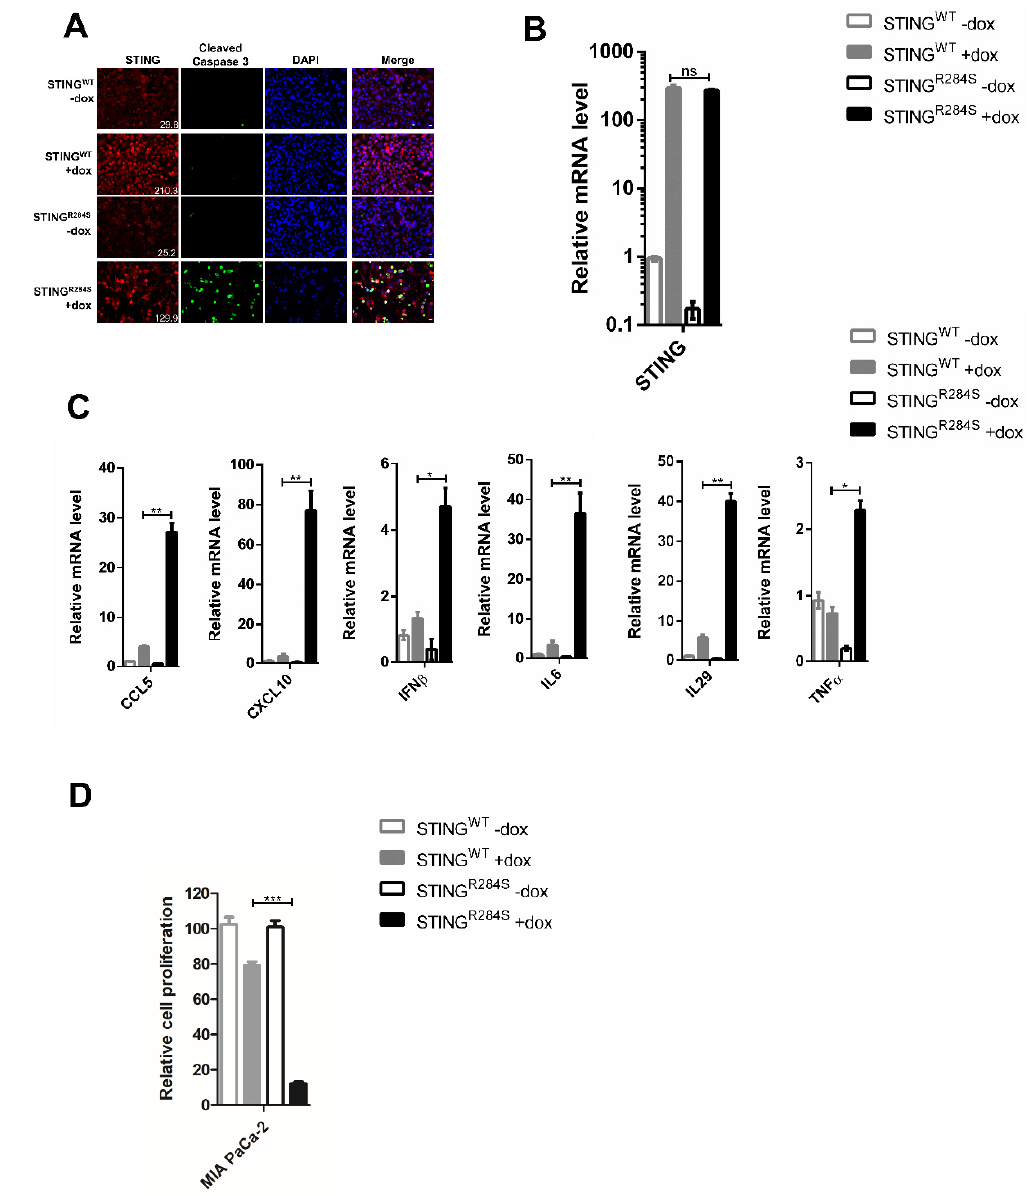
Figure 3. Ectopic expression of dox-inducible STING R284S induces key antitumor cytokine production and cell death in PDAC cells. ( A – C ) MIA PaCa-2 cells stably expressing STING WT or STING R284S were treated with or without 5 µ g/mL dox for 48 h. ( A ) The cells were stained for STING (Red) and Cleaved Caspase-3 (Green). The mean fluorescence intensity of the STING images was quantified using ImageJ software and denoted at the bottom right corner. Scale bar: 20 µ m. ( B ) STING WT and STING R284S expression were confirmed by RT-qPCR. ( C ) The mRNA levels of the indicated genes were measured by RT-qPCR and normalized to GAPDH mRNA levels. The values for untreated STING WT cells were set to 1. ( D ) MIA PaCa-2 cells stably expressing STING WT or STING R284S were treated with or without 5 µ g/mL dox. At 96 h post-treatment, cell viability was measured by the CellTiter-GLO 3D cell viability assay. Error bars represent the SEM of three independent experiments. (ns: not significant, * p < 0.05, ** p < 0.01, *** p <